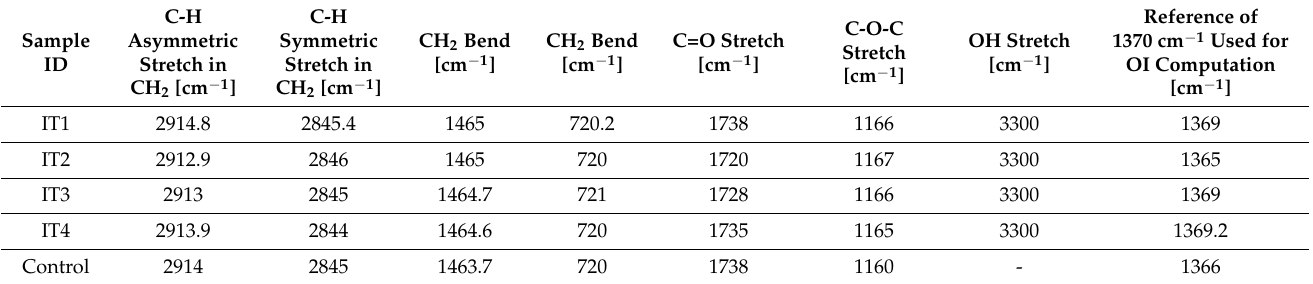
Table 3. Wavenumbers associated with the peaks identified in the FTIR spectra for the five tested samples.